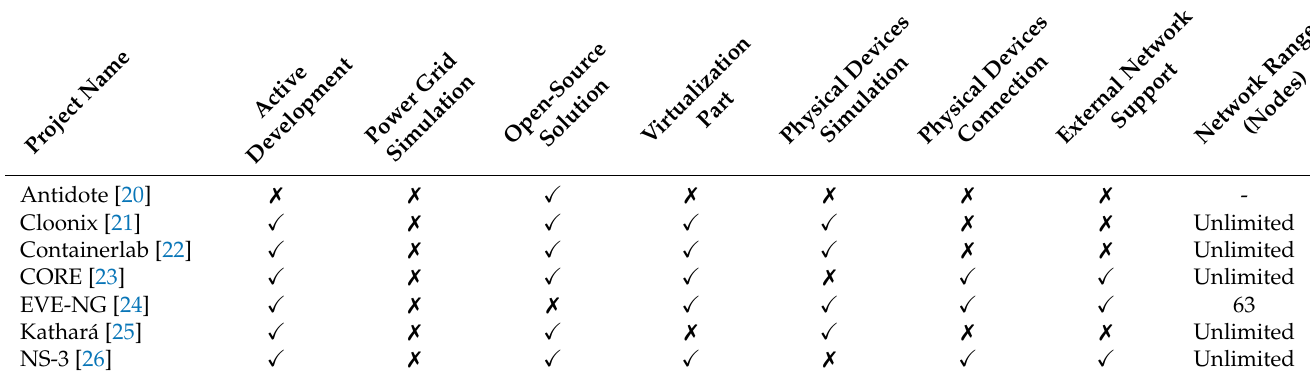
Table 1. Comparison of Available Data Network